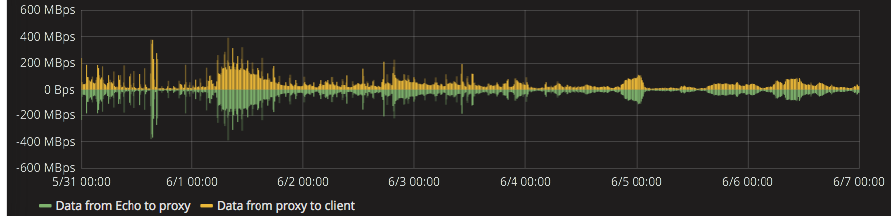
Figure 6: Network Usage over one week for one CMS AAA proxy after changes to the caching. Inflowing data to the proxy is shown as negative and outflowing data as